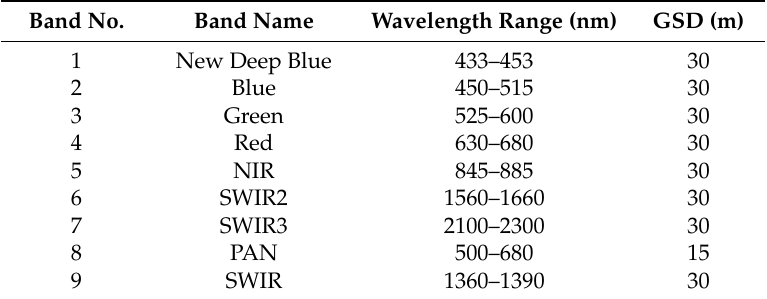
Table 1. Band characteristics of Landsat 8 OLI data.